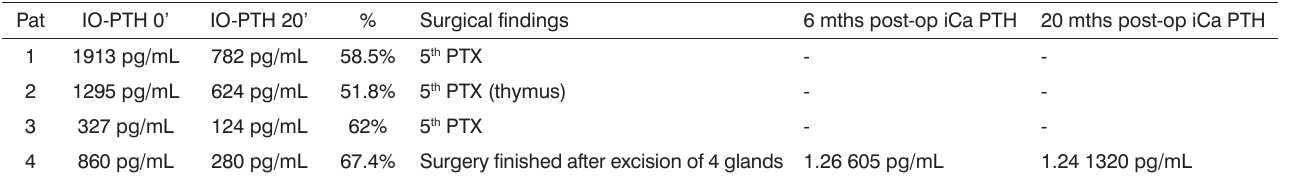
Table 5. Patients with IO-PTH decrease less than